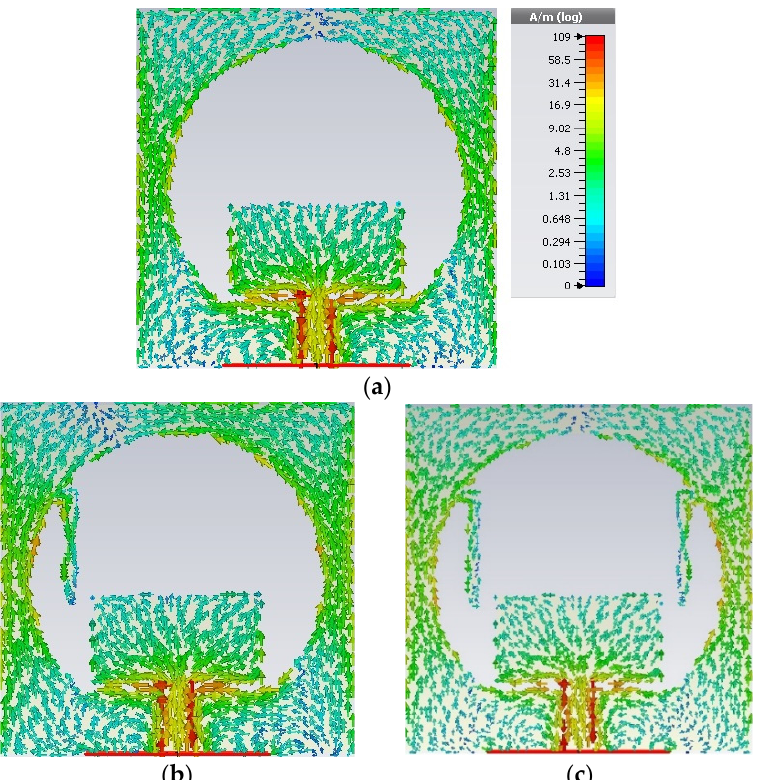
Figure 2. Surface current of the proposed antenna at the operating frequency of 2.45 GHz: ( a ) without ILSS, ( b ) with single-arm ILSS and ( c ) two-arm ILSS.